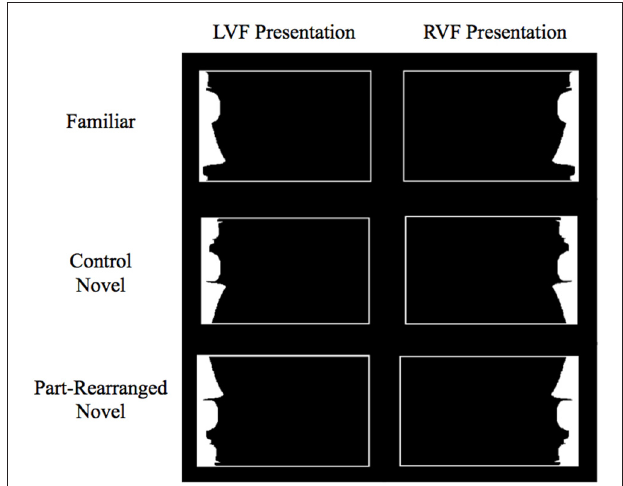
FIGURE 2 | Example stimuli in each condition in Peterson et al. (2012) and the current study. Subjects were asked to fixate on a cross in the center of the screen during stimulus presentation. Stimuli were lateralized to the left visual field (LVF) or right visual field (RVF). Exemplar shown here is the standing